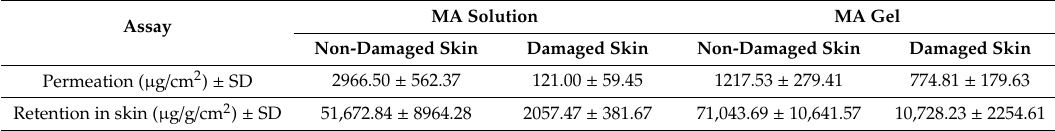
Table 2. Sb V permeation across the skin barrier and Sb V retained after 27 h in damaged and non-damaged skin.